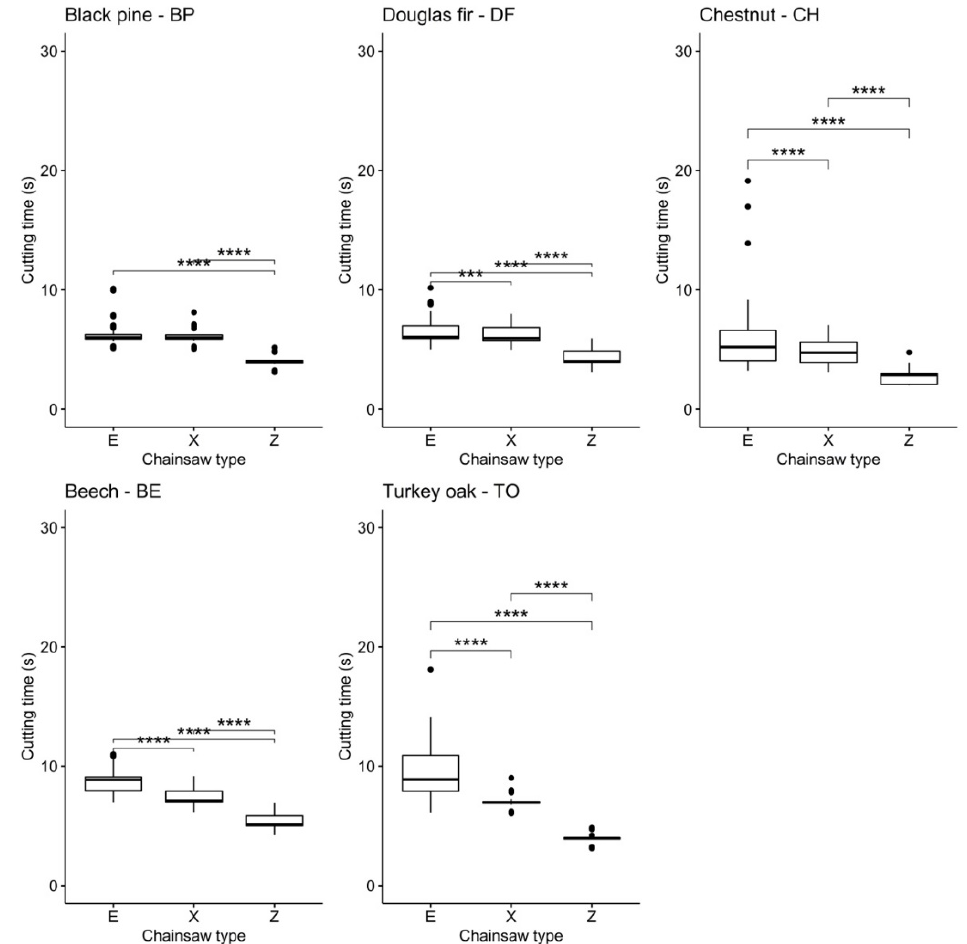
Figure 3. Results of the cutting-time analysis applied per species and chainsaw type. The median and spreading-range values of the cross-cut times are represented. The significance of the pairwise comparison following the Wilcoxon test with Bonferroni adjustment is reported in the brackets. p -level: **** = 0.0001; *** = 0.001; ** = 0.01; * = 0.05; – = not significant.